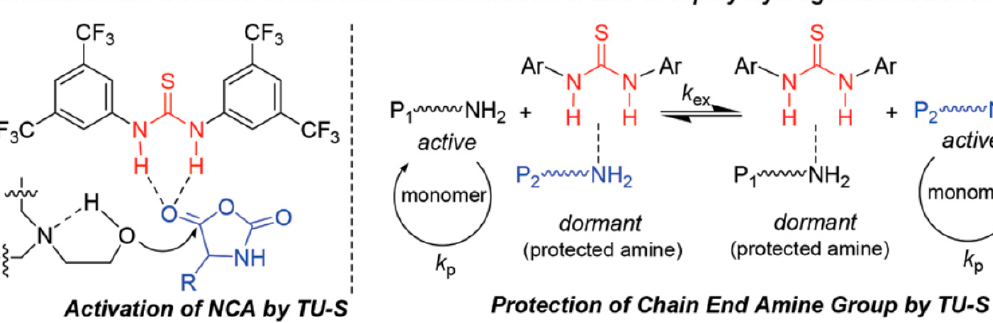
Figure 15. Strategy reported by Zhao et al. for the living polymerization of α -amino acid NCAs. Reproduced with permission from reference [74].